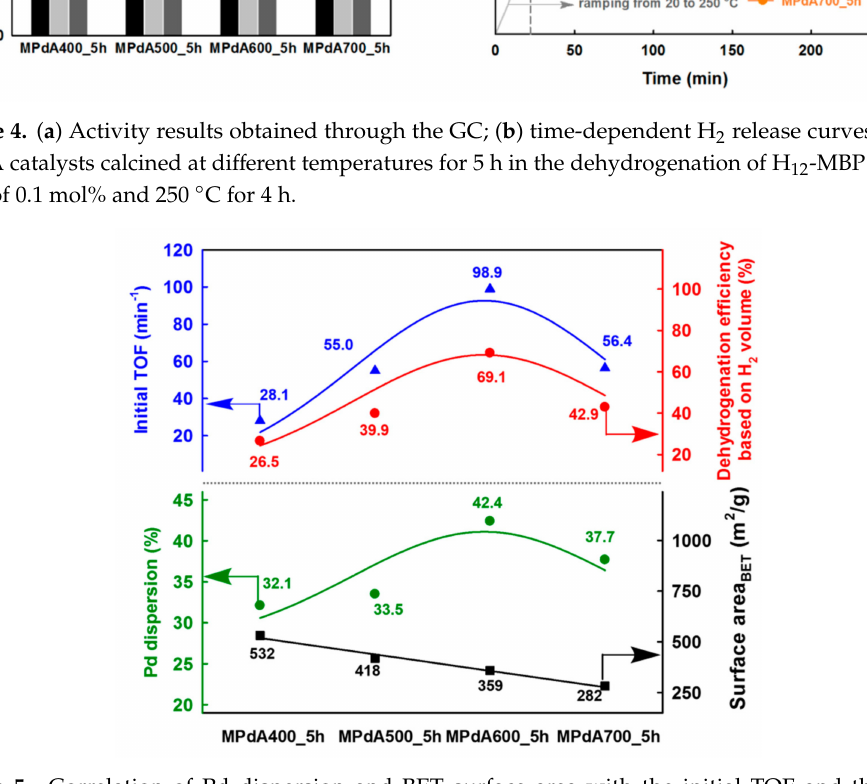
Figure 5. Correlation of Pd dispersion and BET surface area with the initial TOF and the final dehydrogenation e ffi ciency calculated from the time-dependent H 2 release curves of the MPdA catalysts calcined at di ff erent temperatures for 5